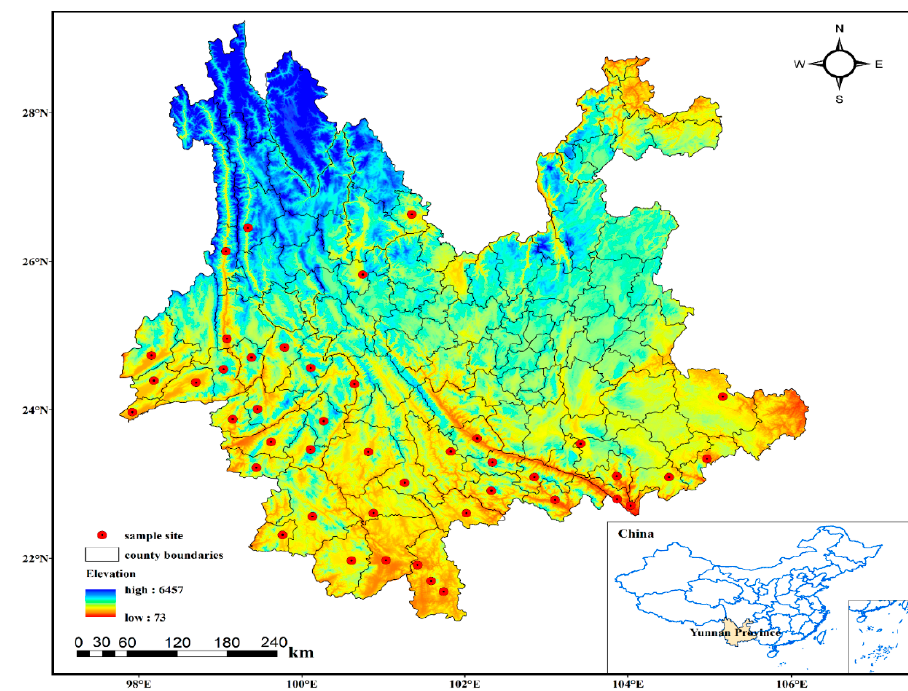
Figure 1. Geographic locations of Arabica coffee in Yunnan, China .